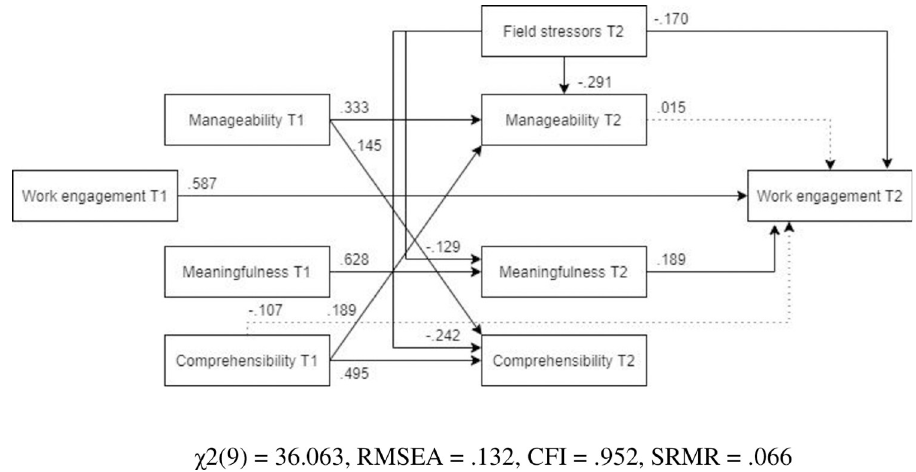
Fig 20. Tested structural equation model of work engagement–males. χ 2(9) = 36.063, RMSEA = .132, CFI = .952, SRMR = .066.